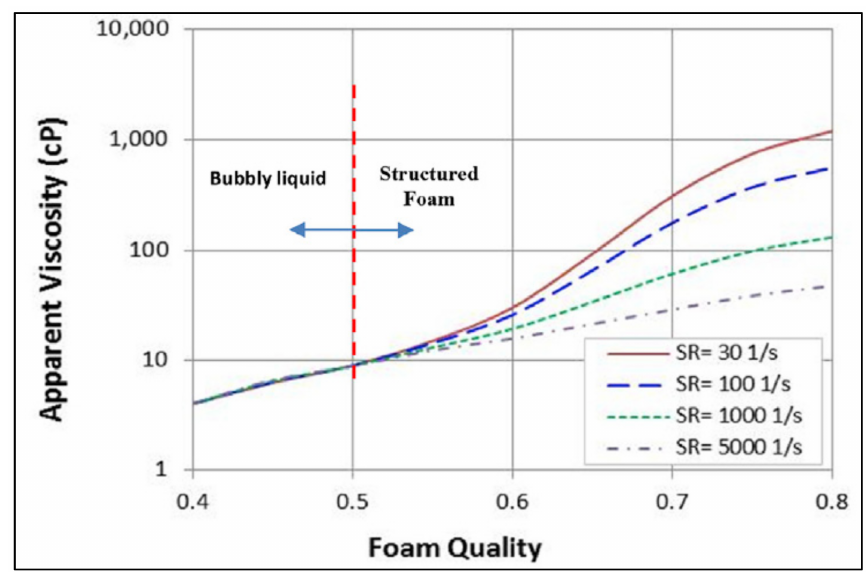
Figure 13. Effect of different shear rates to apparent viscosity against foam quality (Reprinted with the permission from Akhtar et al. [55]). Copyright, 2017 Elsevier